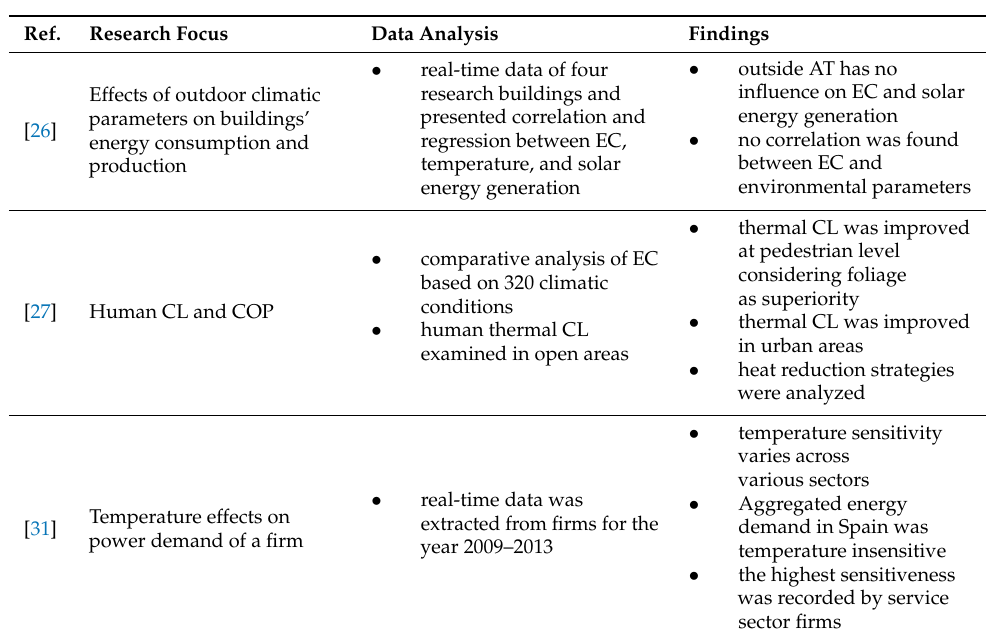
Table 2. Related